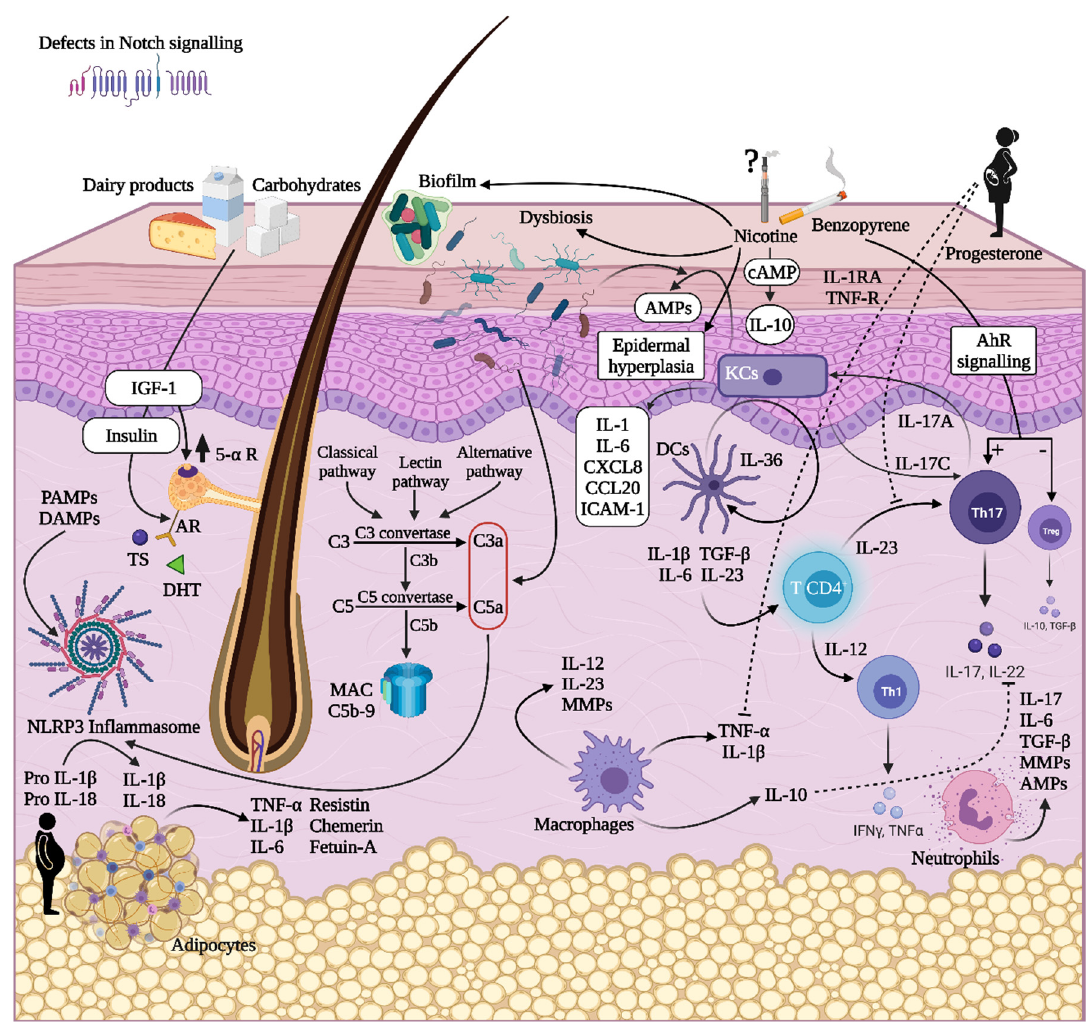
Figure 1. The main pathogenetic events in HS. Created with BioRender.com. Abbreviations: IGF-1, insulin-like growth factor 1; AR, androgen receptor; TS, testosterone; DHT, dihydrotestosterone; 5- α R, 5- α -reductase; PAMPs, pathogen-associated molecular patterns; DAMPs, damage-associated molecular patterns; NLRP3, nucleotide-binding oligomerization domain (NOD)-, leucine-rich repeat (LRR)-, and pyrin domain (PYD)-containing protein 3; TNF- α , tumor necrosis factor alpha; IL, interleukin; MAC, membrane attack complex; MMPs, matrix metalloproteinases; TGF- β , transforming growth factor- β ; AMPs, antimicrobial peptides and proteins; CXCL8, chemokine (C-X-C motif) ligand 8; CCL20, chemokine (C-C motif) ligand 20; ICAM-1, intercellular adhesion molecule 1; cAMP, cyclic adenosine monophosphate; AhR, aryl hydrocarbon receptor; KCs, keratinocytes; DCs, dendritic cells; IFN- γ , interferon- γ .